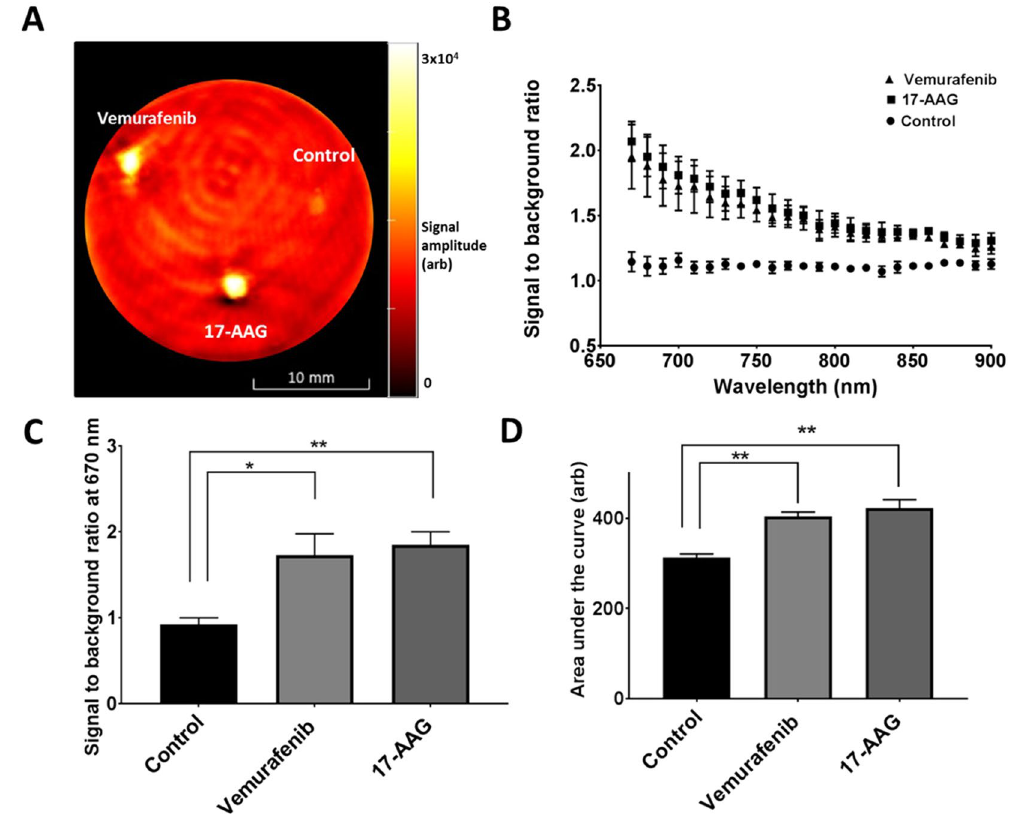
Figure 3. Changes in PAI signals following melanoma cell differentiation. ( A ) Optoacoustic image of a phantom with the control and treated cell inclusions at 670 nm absorption. Circular inclusions containing control cells, and cells treated with 17-AAG and vemurafenib to the right, bottom and left of the phantom, respectively (scalebar: 10 mm). ( B ) Signal to background ratio plot of the untreated cells ( ● ) and cells treated with 17-AAG (  ) and vemurafenib ( ▴ ), obtained by measuring the ratio of mean PA signal intensities of the inclusions to the background, at a wavelength interval of 10 nm from 670 nm–900 nm. The error bars represent standard error of mean (n = 3). ( C ) Bar chart comparing the signal to background ratio at 670 nm, between control and treated cells. ( D ) Comparison of area under the curve of the SBR plots between the treated and control cells. The asterisk sign indicates the significant difference between the mean of the groups ( * p < 0.05, ** p <